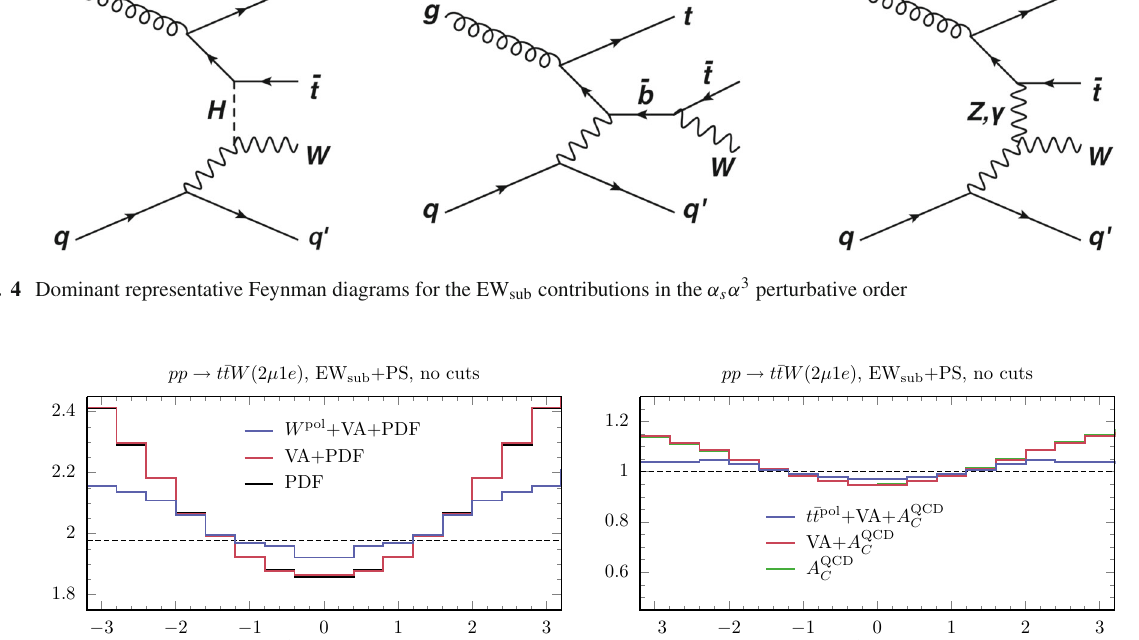
on average harder and more forward (emerging from t ¯ tW + ) as compared to the negatively charged lepton pair (emerging from t ¯ tW − ). Even though this effect is opposite to the one from the top-quark pair spin correlations, the latter is always dominant, resulting in a larger charge ratio for the 2ss (cid:7) as compared to the 3 (cid:7)